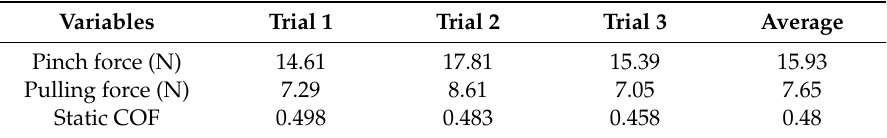
Table 1. Measurements recorded from the right hand of a volunteer.